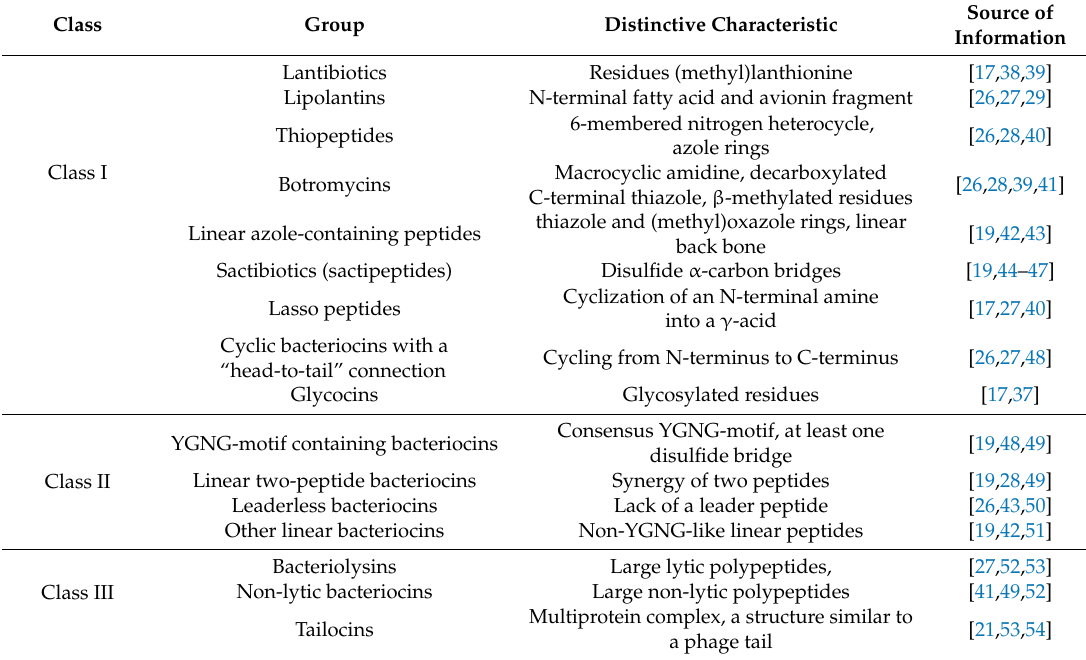
Table 2. Classification of bacteriocins of Gram-positive